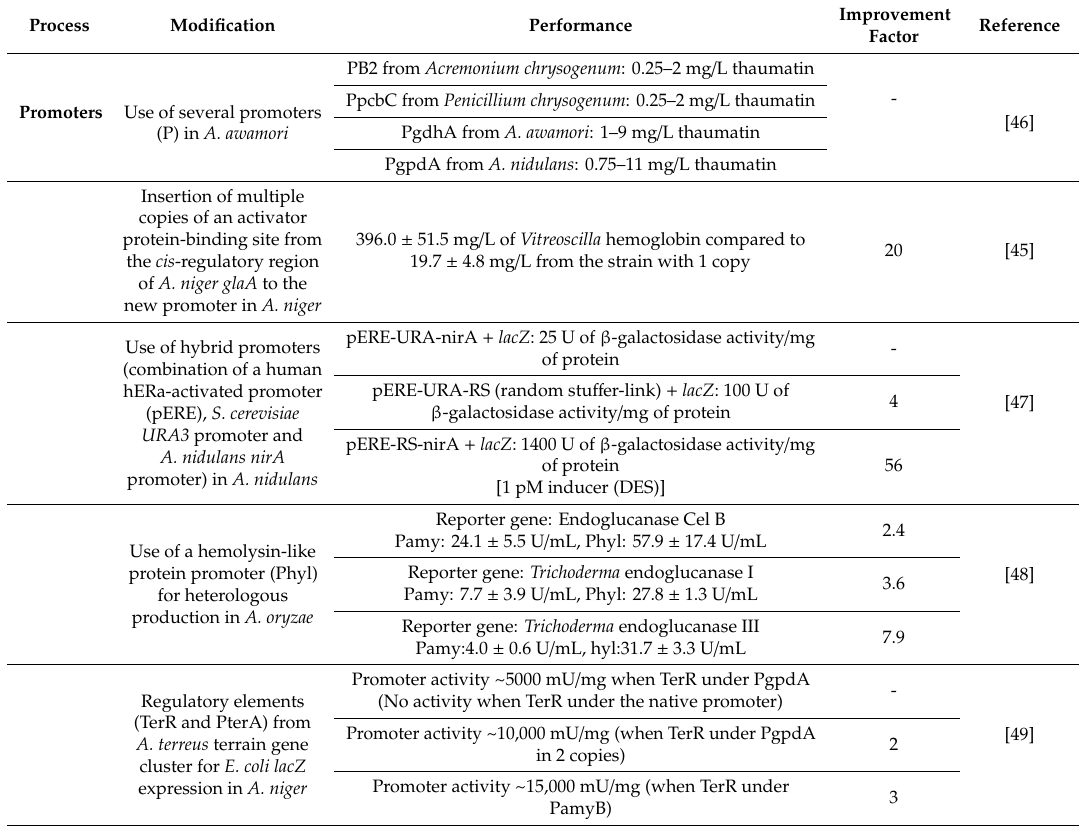
Table 2. Approaches for improving recombinant protein production through promoter engineering. Process Modification Performance